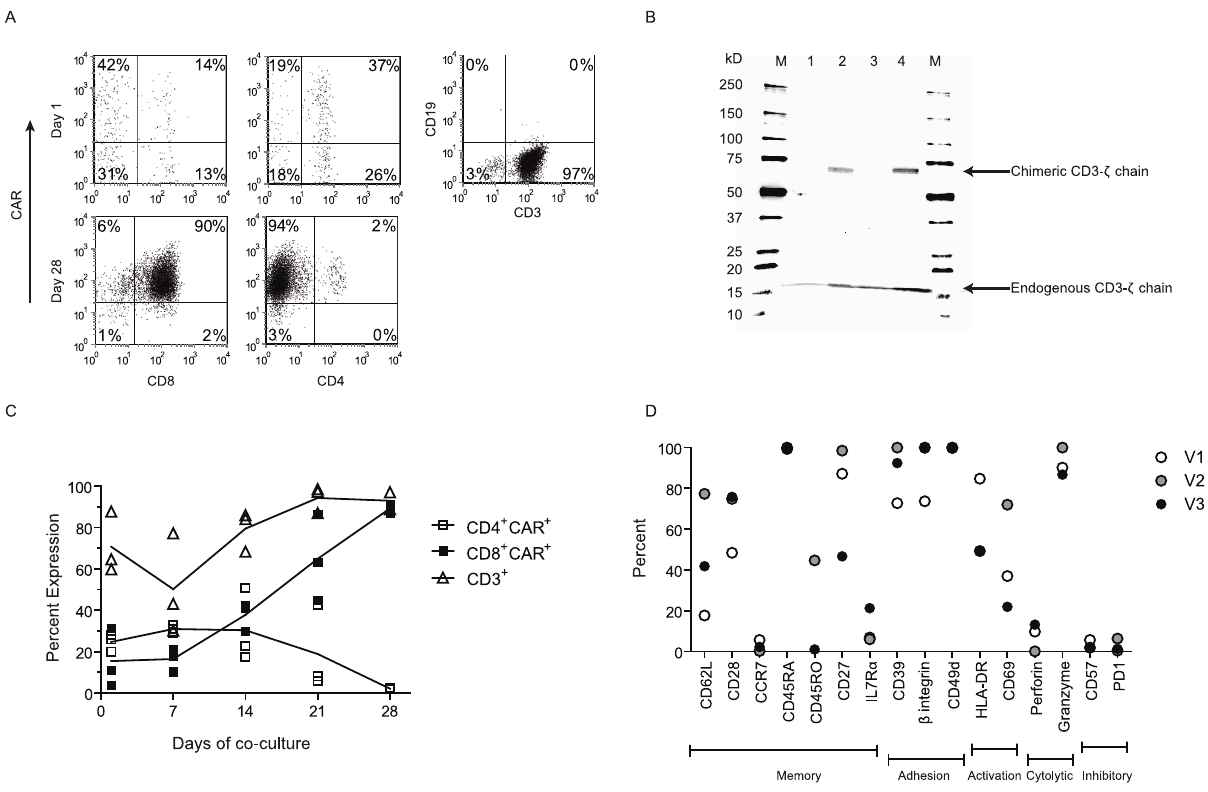
Figure 3. Phenotype of CAR + T cell. (A) Expression of CD19RCD28 CAR on T cells day after electroporation (culture day 1) and after 28 days of co- culture on aAPC clone # 4 along with lack of CD19 + aAPC. (B) CAR expression by western blot analysis using CD3- f specific antibody. Whole cell lysates were run on SDS-PAGE under reducing conditions. Molecular weight marker (M), Parental Jurkat cells (Lane 1), CD19RCD28 + Jurkat cells (Lane 2), CAR neg control T cells (Lane 3) and CD19RCD28 + T cells (Lane 4). (C) Percent expression of CD3 + , CD4 + CAR + and CD8 + CAR + T cells with in a lymphocyte gate in cultures over time. Each symbol represents a separate experiment; the solid lines are mean of the three validation experiments. (D) Immunophenotype of memory/naı¨ve, adhesion, activation, cytolytic and exhaustion markers on CAR + T cells at the end (d28) of co-culture.